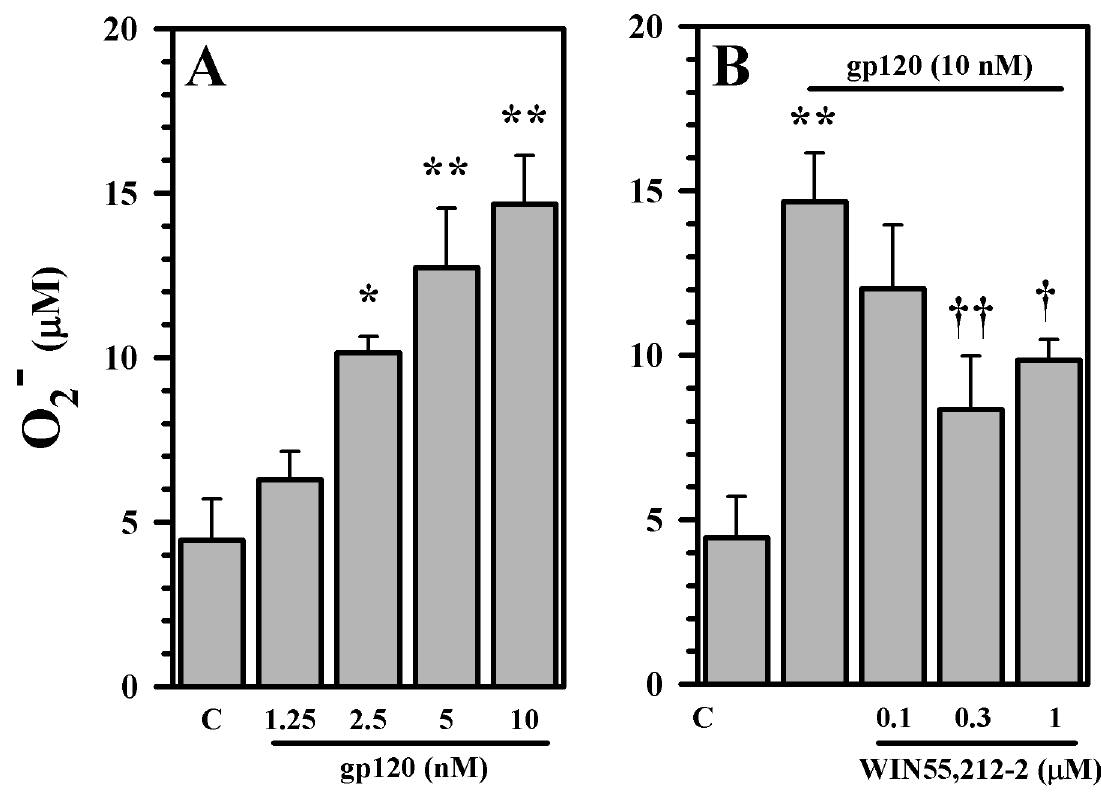
Figure 9. Blockade of gp120-induced superoxide production. Highly purified human microglial cell cultures were A ) untreated (C) or treated with gp120 or B ) untreated (C) or pretreated with WIN55,212-2 for 3h prior to gp120 treatment for 48h followed by measurement of O 2- . Data are mean ± SD of triplicates and representative of 2 separate experiments using different brain tissue specimens. * p<0.05, ** p<0.01 vs. control (C); † p<0.05, †† p<0.01 vs. gp120. doi: